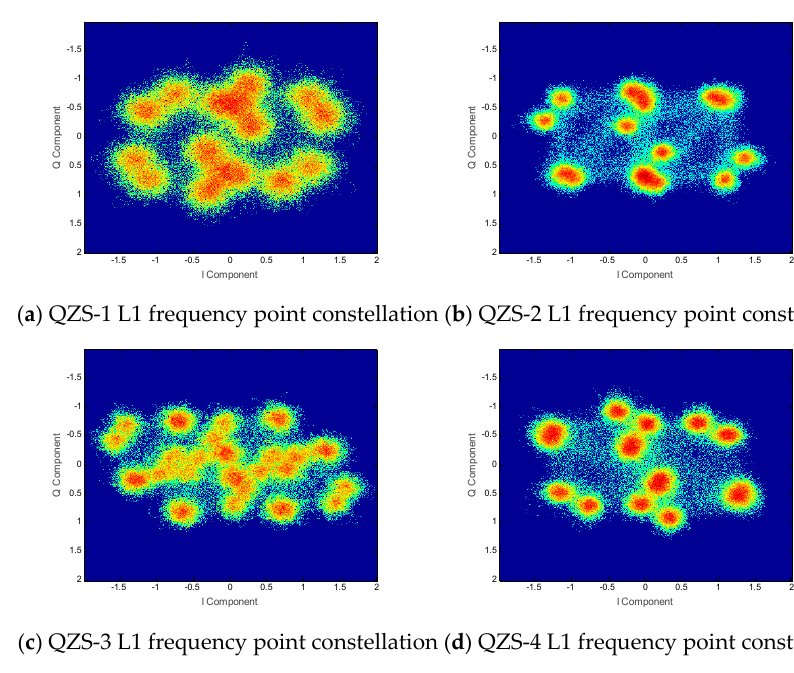
Figure 4. QZSS satellite L1 frequency constellations.